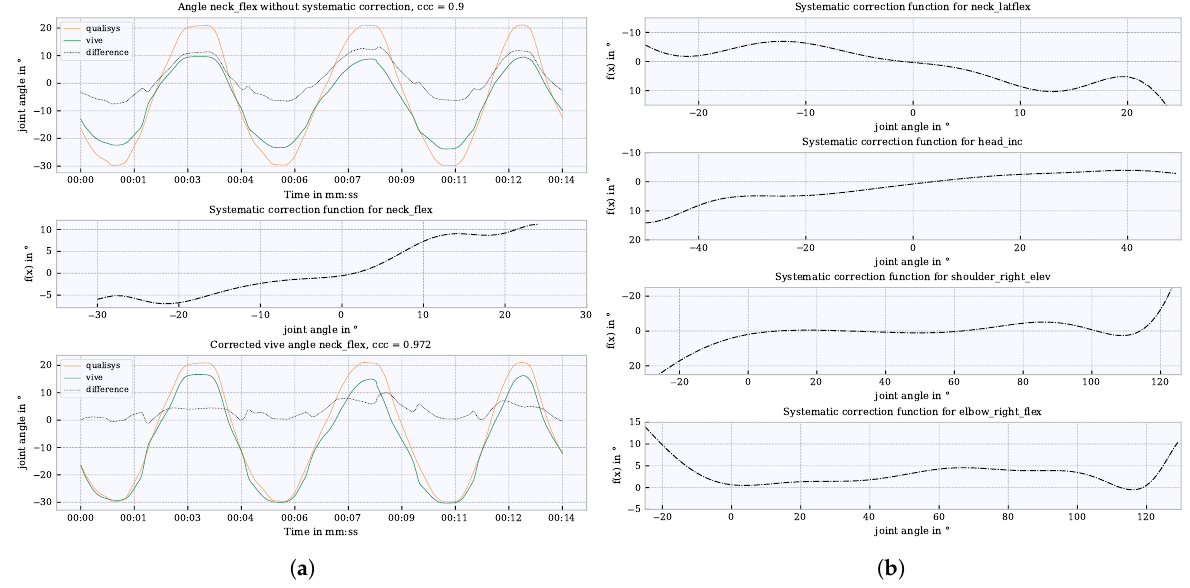
Figure 8. Systematic correction by polynomial regression function. ( a ) Systematic differences using the example of neck flexion (upper graph); correction function (middle graph); corrected joint angle (lower graph); ( b ) further correction functions using the 3 tracker configuration as an